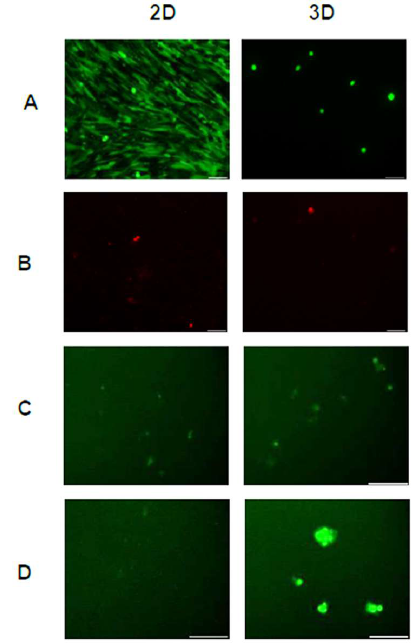
Figure 3. Live/dead assay images depict ( A ) live and ( B ) dead cells in the scaffold-free 2D and 3D conditions on day 7. Uptake of acetylated LDL (green) by cells cultured in 2D and 3D conditions on ( C ) day 0 and ( D ) day 7. Scale bars = 100 μm.